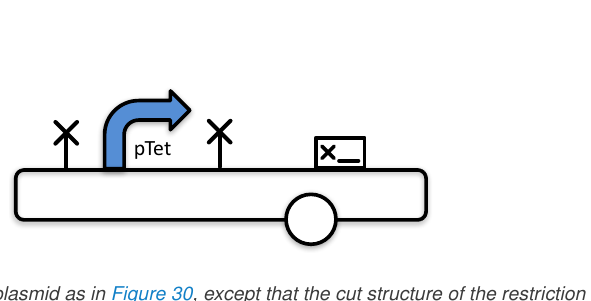
Figure 32: Promoter stored in a plasmid as in Figure 30, except that the cut structure of the restriction sites before and after the promoter is not specified.